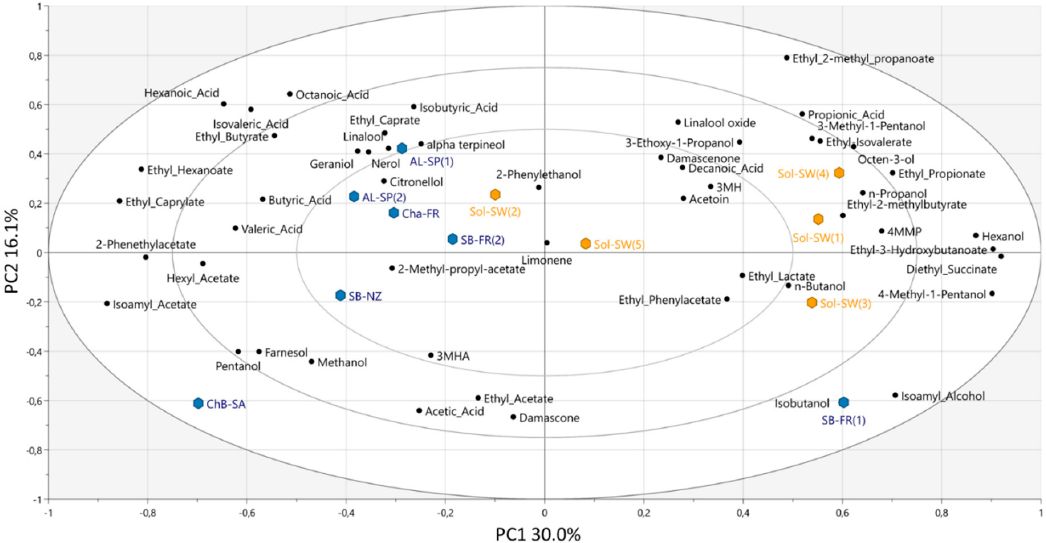
Figure 4. PCA biplot showing the distribution of the wines according to their volatile composition. Solaris wines are colored in orange and non-Solaris in blue.